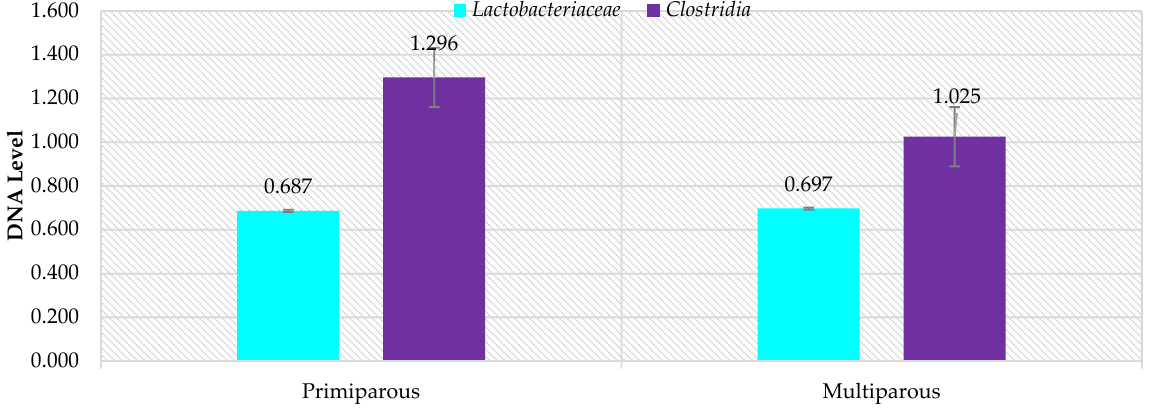
Figure 4. RNE levels of selected bacterial families in the gastrointestinal tract of ewes in relation to parity. In contrast, no differences were demonstrated for the Lactobacillaceae and Clostridia families (Firmicutes phylum) ( p < 0.05). Levels were similar for both families (Figure 4) in terms of parity. However, there were differences between particular animals (Figure 5), where the most abrupt values were again found for primiparous ewes in terms of Clos ‐ tridia family, compared to multiparous ewes. Lactobacillaceae family levels were similar in both primiparous and multiparous ewes.